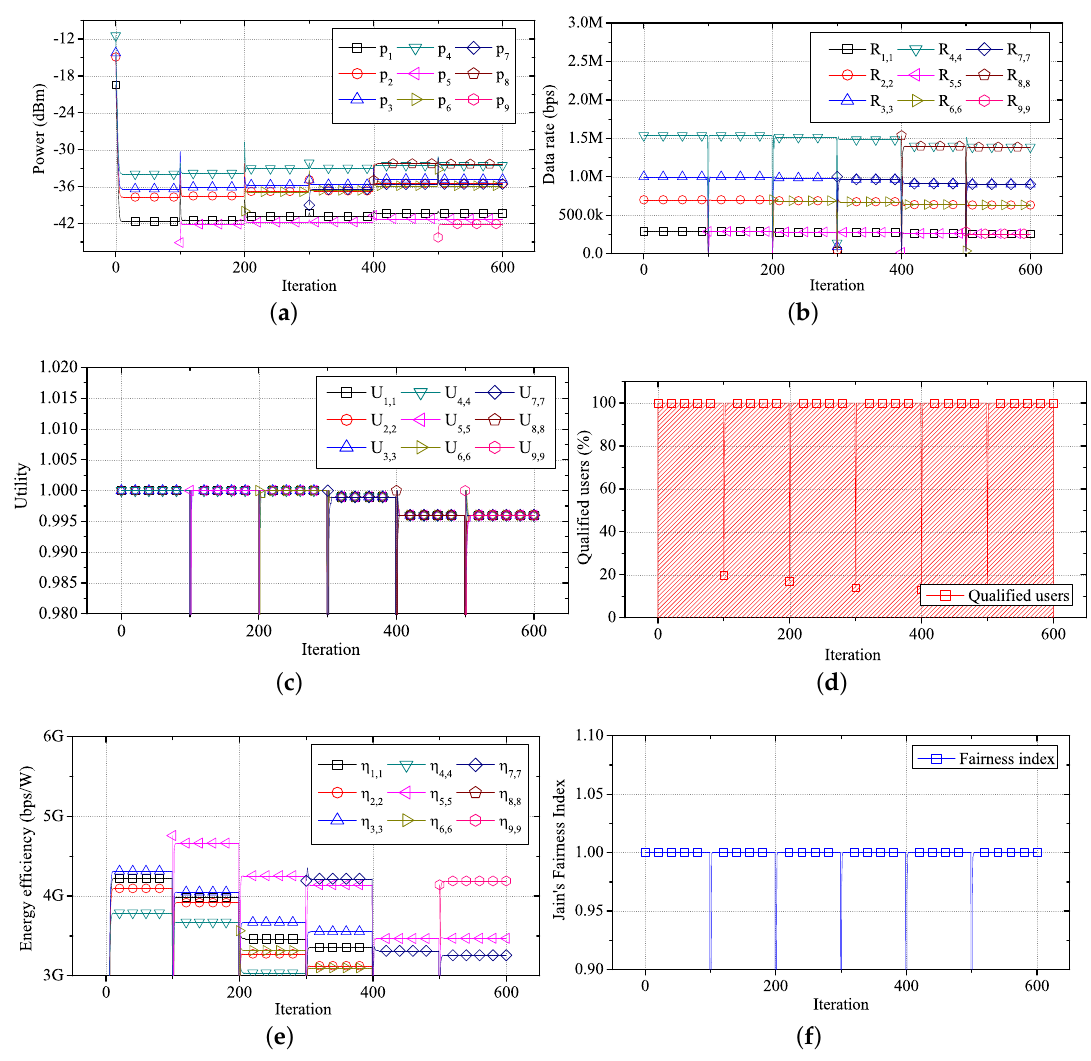
Figure 13. Performance of FTPC-U over time in the entry model. ( a ) Change in transmit power over time in the entry model; ( b ) change in data rate over time in the entry model; ( c ) change in utility over time in the entry model; ( d ) change in qualified users over time in the entry model; ( e ) change in energy efficiency over time in the entry model; ( f ) change in fairness over time in the entry